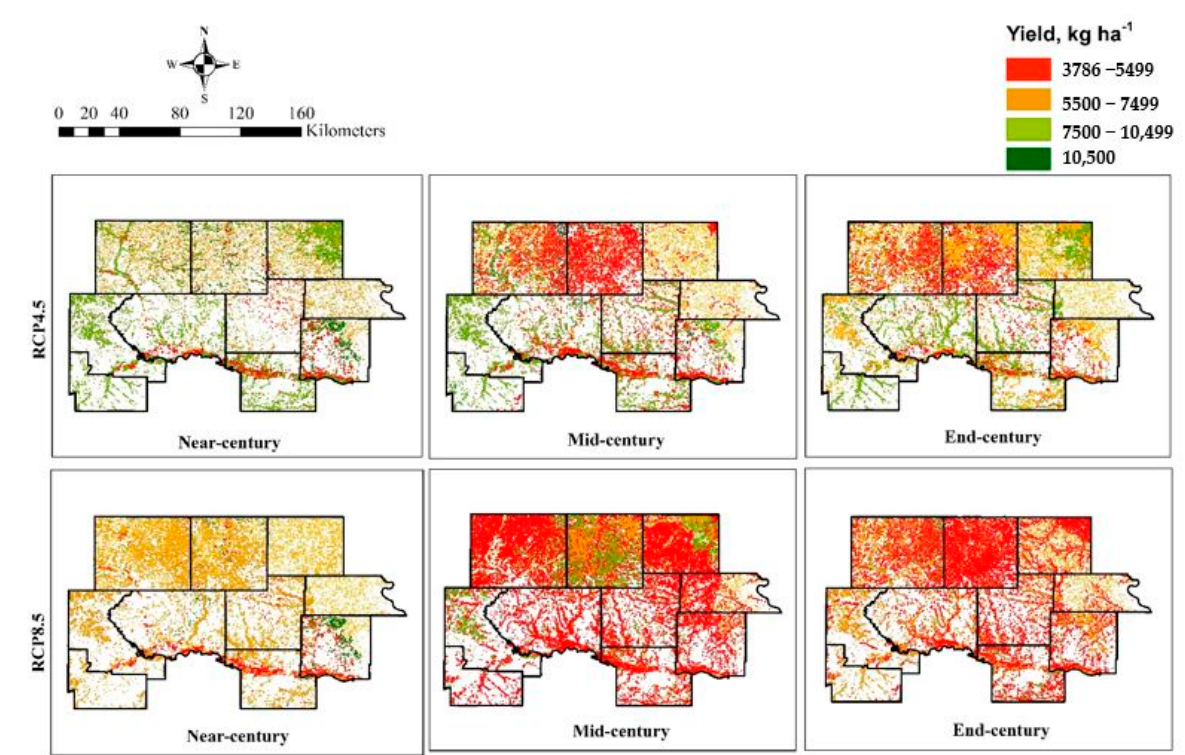
Figure 10. Yield variation under changing climate in ten maize-producing counties in northeastern Kansas under three study periods (near, mid, and end-century) for RCP4.5 and RCP8.5. The red color stands for low-yielding and the green for the high-yielding region.